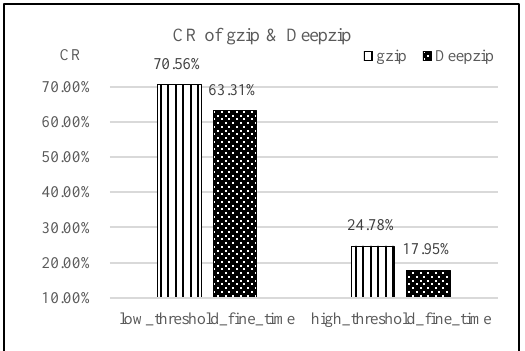
Fig. 8. Compression ratio of gzip and